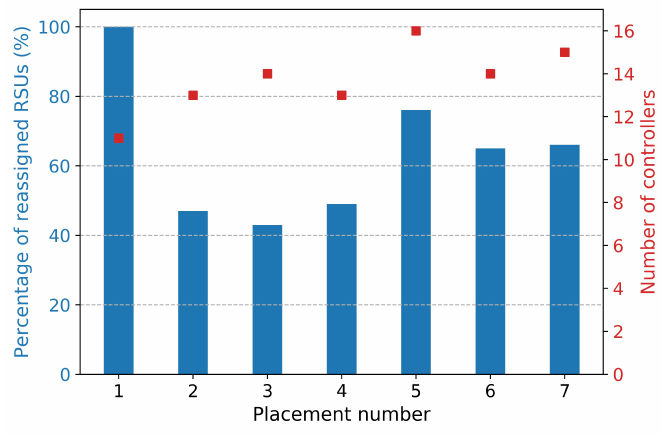
Figure 11. Percentage of reassigned RSUs.